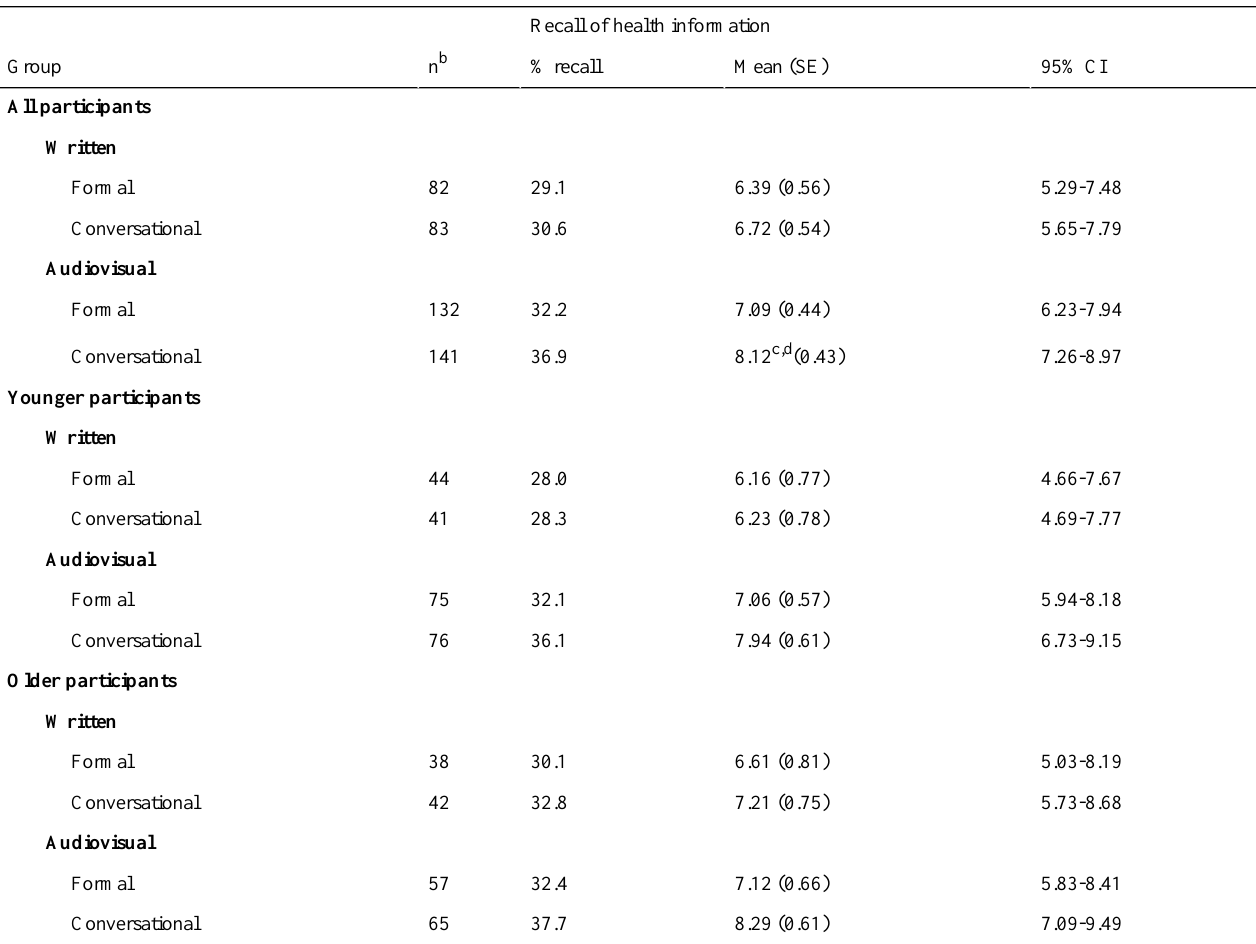
Table 4. Synergistic effects of combining modality and narration style on recall of eHealth information in younger and older adults.